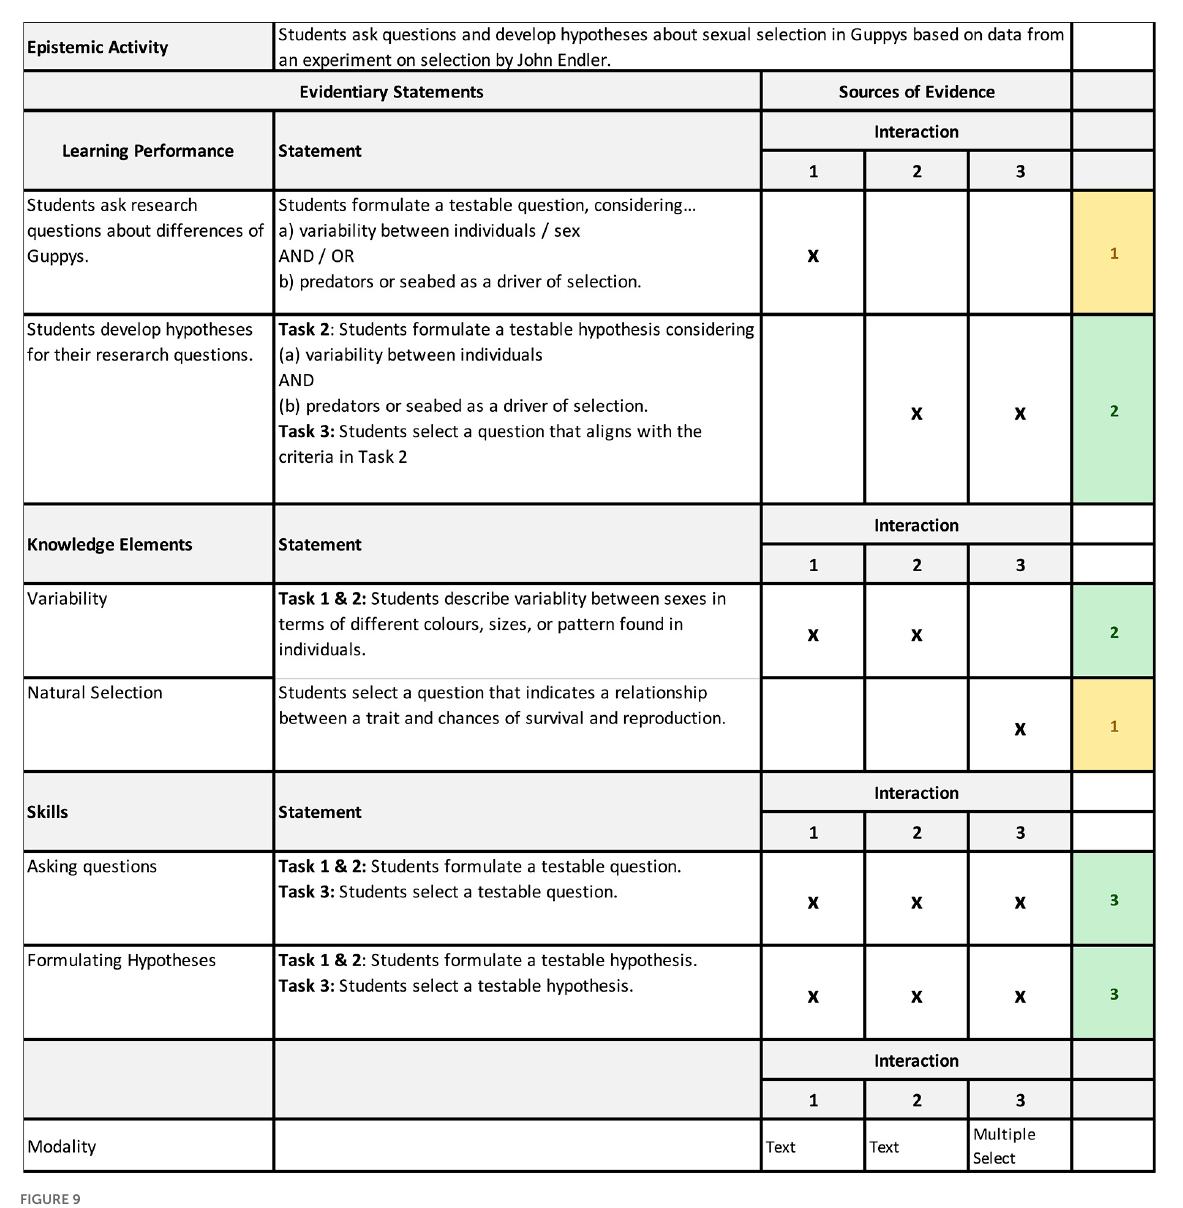
FIGURE9 Evidentiary statement excerpt from an asking question epistemic activity [Tasks adapted from: Staatsinstitut für Schulqualität und Bildungsforschung München (2016, 08. Mai). Aufgabe: Guppys sind unterschiedlich. https://www.lehrplanplus.bayern.de/sixcms/media.php/